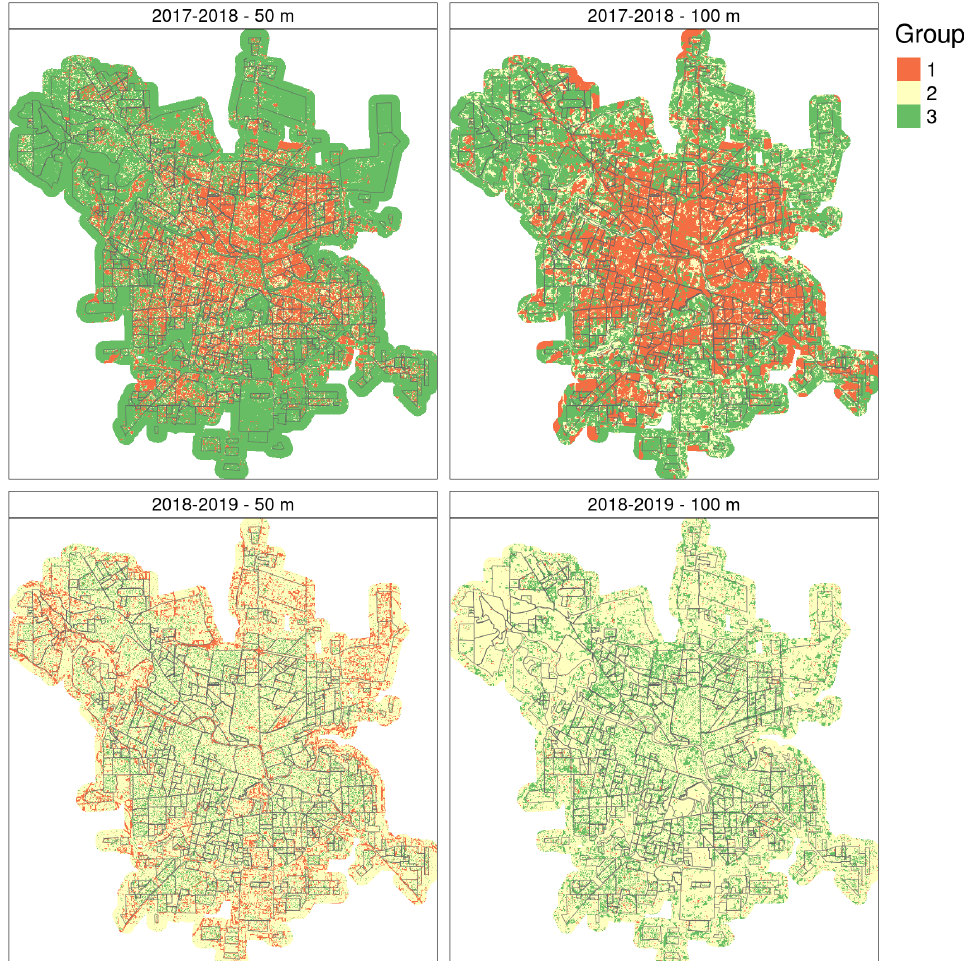
Figure 5. Distribution of temporal clusters as predicted by random forest models for 2017–2018 and 2018–2019 using remote sensing variables taken at ≈ 50- and 100-m radii. City of Córdoba,